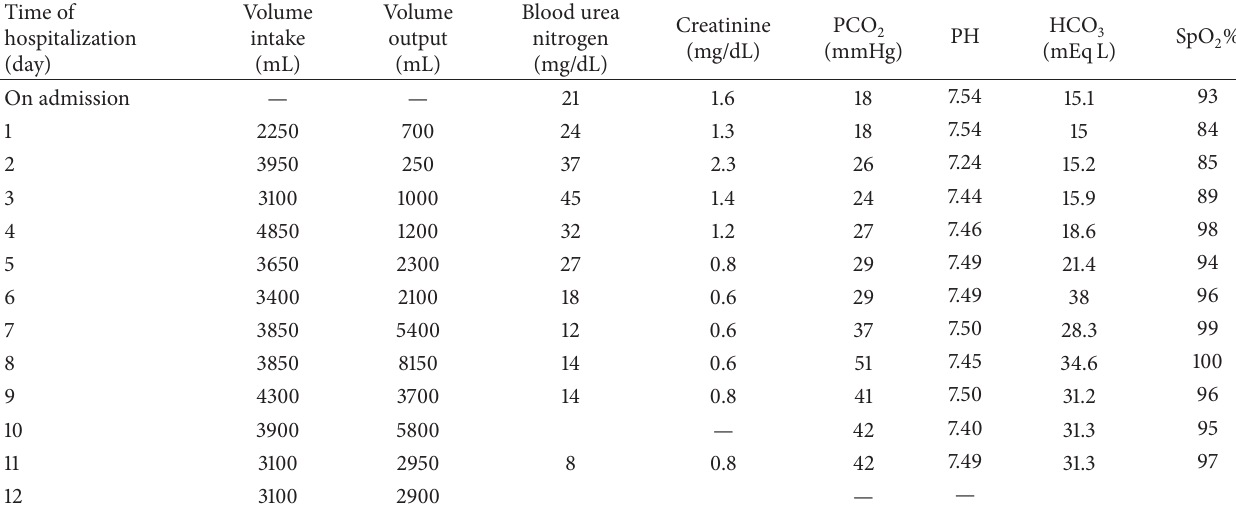
Table 2: Different variables of the patient (on admission and at 8.00 a.m. each day): intake and output volume, blood urea nitrogen (normal value ranges: 9–20 mg/dL), creatinine (normal value ranges: 0.7–1.4 mg/dL), peripheral venous blood gases including partial pressure of carbon dioxide (normal value ranges: 40–52 mmHg), venous blood pH (normal value ranges: 7.31–7.41), bicarbonate (normal value